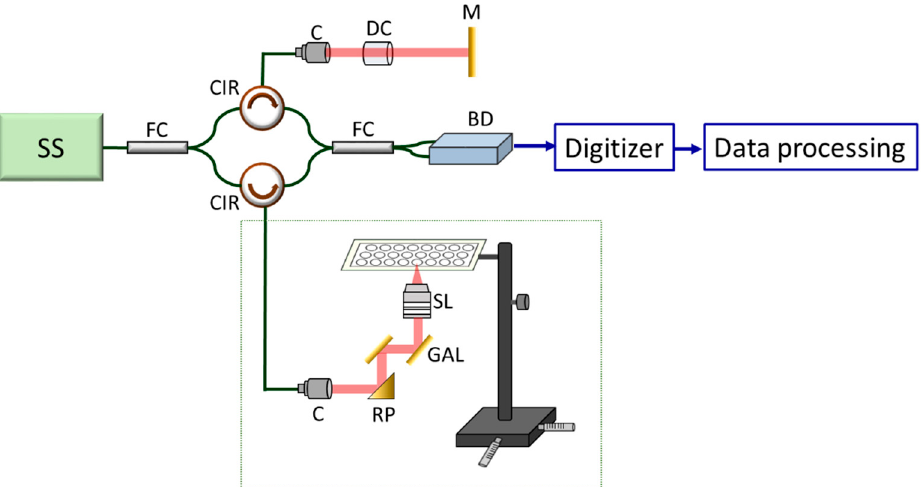
Figure 1. Schematic diagram of the optical coherence tomography (OCT) setup for cell imaging. SS: swept source, FC: fiber coupler, CIR: circulator, C: collimator, DC: dispersion compensator, M: mirror, BD: balanced detector, RP: right-angle reflective prism, GAL: galvanometer, SL: scanning lens.